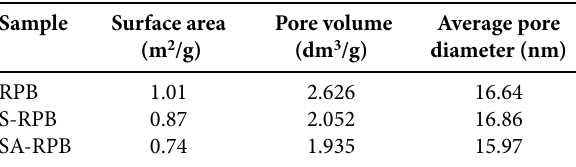
Table 2. Porous textural parameters of RPB, S-RPB, and SA-RPB samples